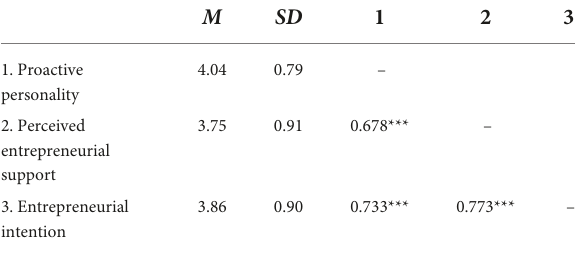
TABLE 2 Means, standard deviations, and Pearson correlation coefficients for key variables ( N = 1,515). M SD 1 2